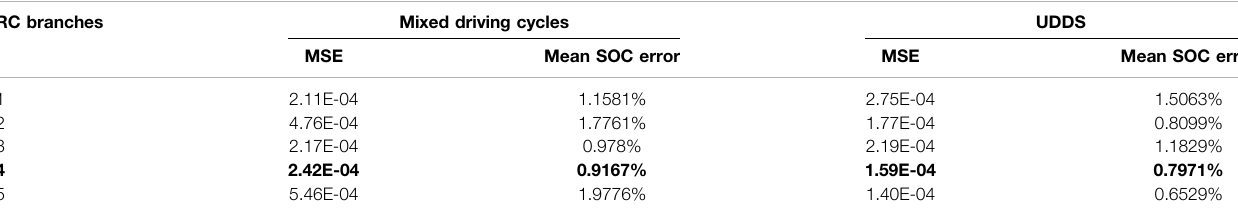
TABLE 15 | Augmented ECM-based AEKF with 10% bias.